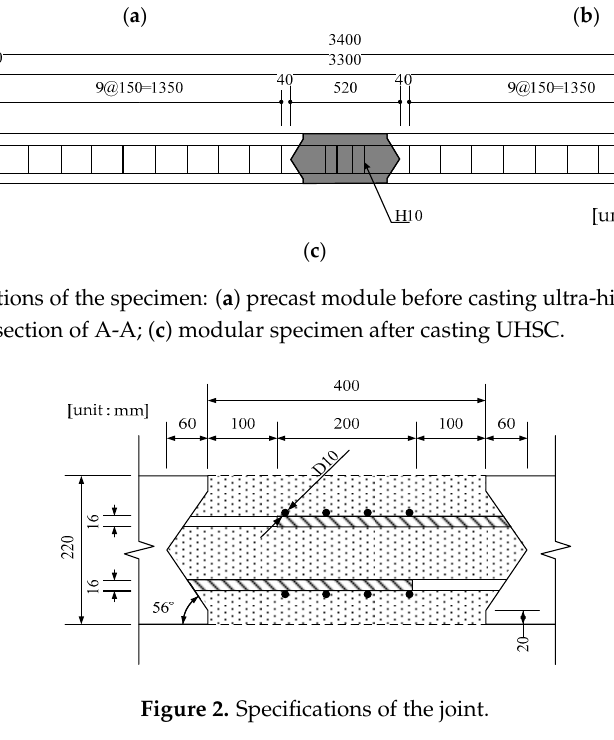
Figure 3. Experimental setup. LVDT: linear variable differential transformer.